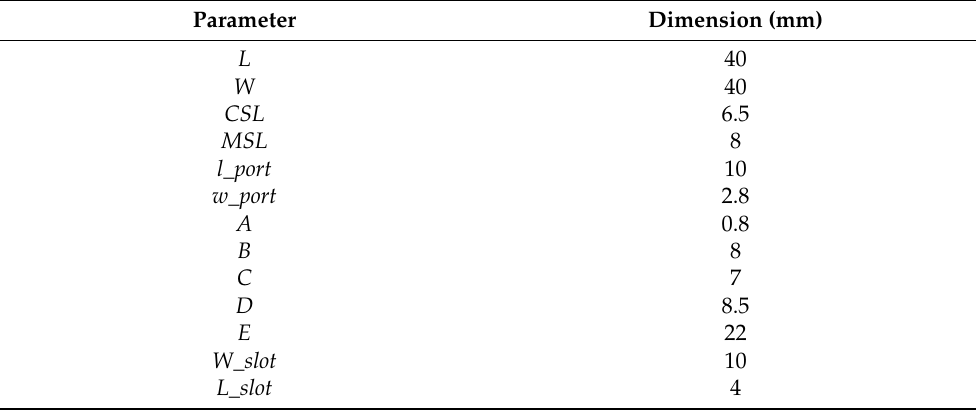
Table 1. Antenna dimensions of the proposed design